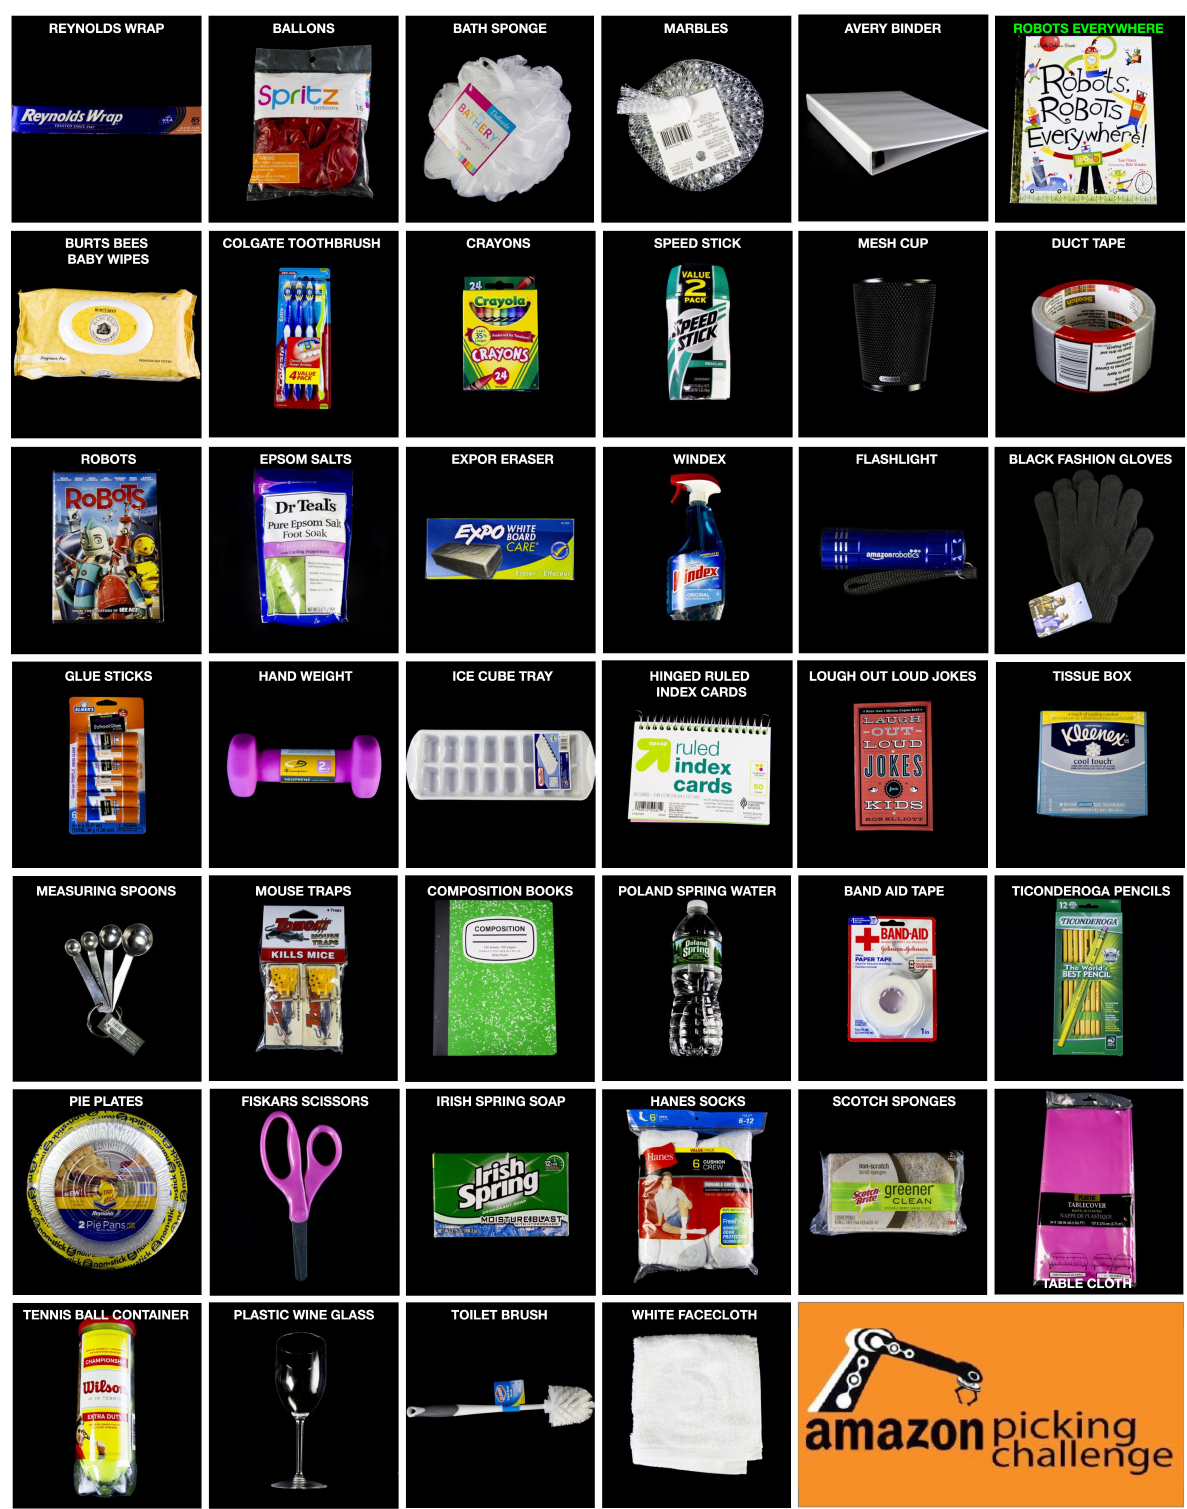
Figure 1. Official set of benchmark items from ARC’17. All these items are known in